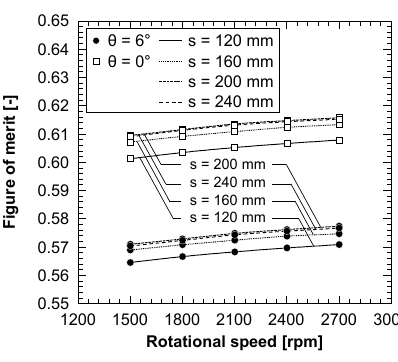
Figure 8. Figure of merit for different rotor spacings and duct diffusion angles.